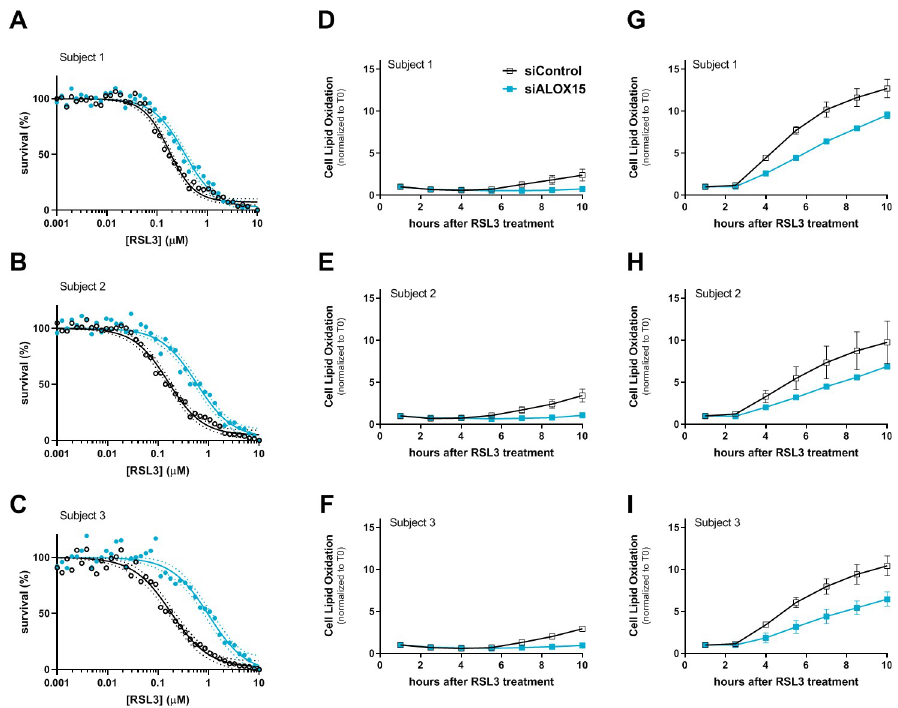
Fig 4. ALOX15 siRNA-mediated gene knockdown partially abrogates ferroptosis in PCH6 patient fibroblasts. (A-C) siRNA knockdown of ALOX15 (siALOX15) decreased the sensitivity of PCH6 patient cells to RSL3-induced cytotoxicity, as assessed by ATP levels at 18h. Summarized results in each PCH6 patient culture from three independent knockdown experiments. Means (circles) and best-fit curves (solid lines) from 4-parameter fits with associated 95% confidence bands (dotted lines) displayed. (D-I) siRNA-mediated knockdown of ALOX15 partially prevented BODIPY 581/591 C11 lipid oxidation induced by RSL3 (60 nM, panels D-F, or 167 nM, panels G-I) in fibroblasts from Subject 1 (D, G), Subject 2 (E, H), or Subject 3 (F, I). Cellular lipid oxidation was measured by changes in green fluorescence by time-lapse video microscopy. Mean ± SEM displayed, N = 6–8 per group. Representative results from two independent studies. Statistical comparison of Area Under the Curve values was performed by unpaired t-test relative to siControl; see S1 Table for summary of results. ALOX15 -targeted siRNA transfection resulted in > 90% reduction in the target mRNA, as assessed by quantitative